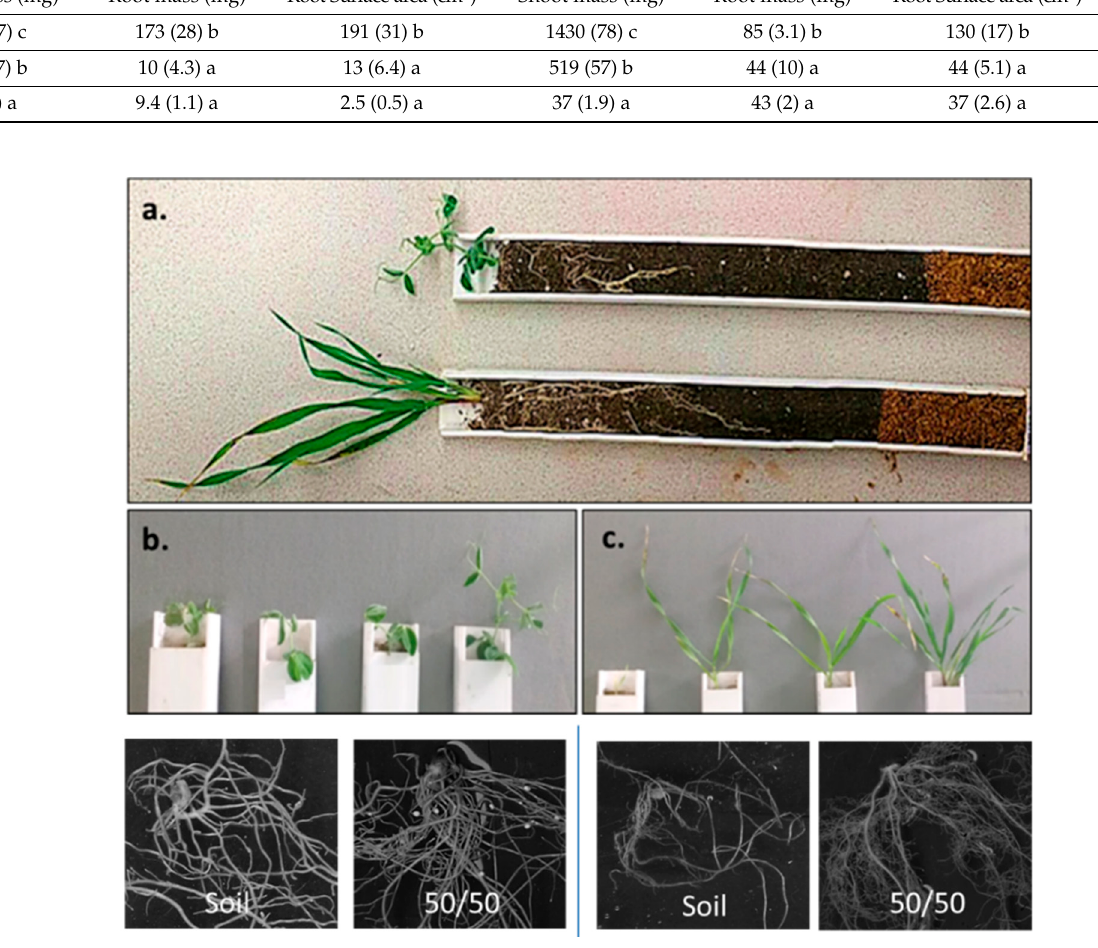
Figure 3. Rhizobox experiment showing; ( a ) pea and barley growth before removal and scanning; ( b ) pea shoot growth with root imagery below; ( c ) barley shoot growth with root imagery below.